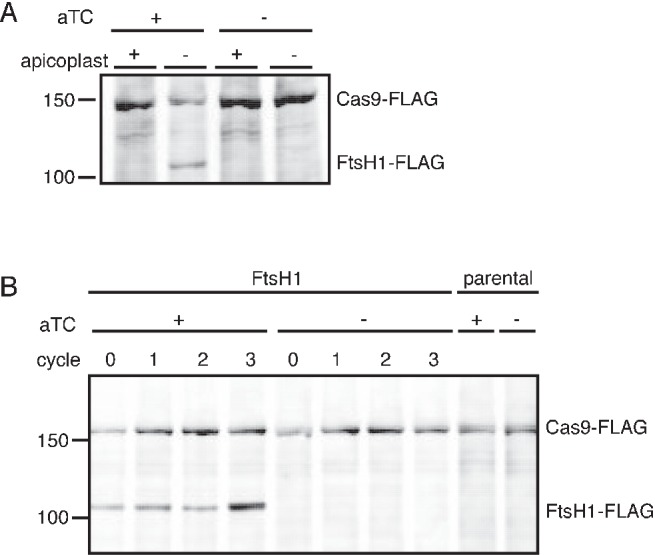
C-terminal cleavage of PfFtsH1 is dependent on the presence of the apicoplast and efficiency of PfFtsH1 knockdown can be assessed in parasites missing their apicoplast.(A) Western blot of PfFtsH-FLAG levels in parasites with and without an apicoplast and with and without aTC induction. Consistent with the previous report of PfFtsH1 C-terminal processing, we were unable to detect full-length PfFtsH1-FLAG using anti-FLAG in parasites with intact apicoplasts (lane 1) (Tanveer et al., 2013; Karnataki et al., 2009). However, in parasites missing apicoplasts, full-length PfFtsH1-FLAG was detectable, suggesting that PfFtsH1 processing requires the apicoplast (lanes 2). PfFtsH1-FLAG is not observed in parasites with or without apicoplasts if there is no aTC induction, indicating that the band representing FtsH-FLAG is specific and not an artifact of missing apicoplasts (lanes 3–4 respectively). All samples contain IPP to rescue growth and Cas9-FLAG is used as a loading control. Each sample was taken at the trophozoite stage. (B) To assess the knockdown efficiency of PfFtsH1, we used a western blot comparing PfFtsH1-FLAG levels in the presence (lanes 1–4) or absence of aTC (lanes 5–8) in IPP-rescued parasites missing their apicoplast. Each sample was taken at the trophozoite stage and cycle 0 indicates 24 hr after the removal of aTC. Lanes 9 and 10 are samples from the parental strain that do not contain the FLAG-tag or the aptamer sequence in the 3’ UTR of PfFtsH1. In each case, Cas9-FLAG was used as a loading control. PfFtsH1-FLAG levels were reduced to undetectable levels at 24 hr after aTC removal, validating our knockdown strategy.